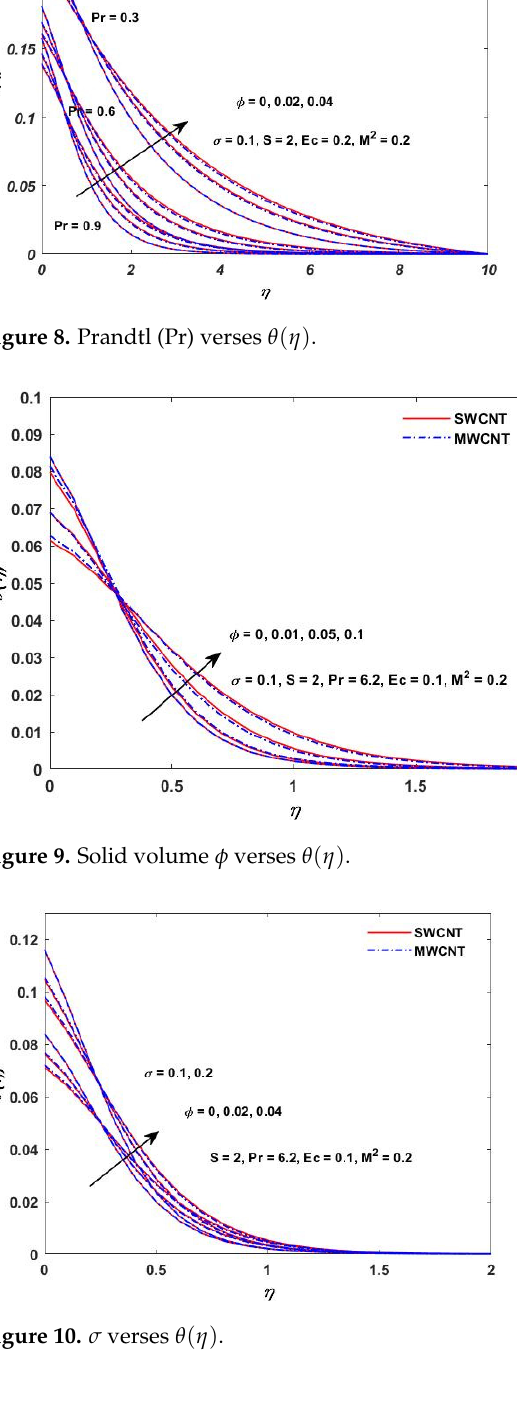
Figure 11. 𝑀 (cid:2870) verses 𝜃(𝜂).